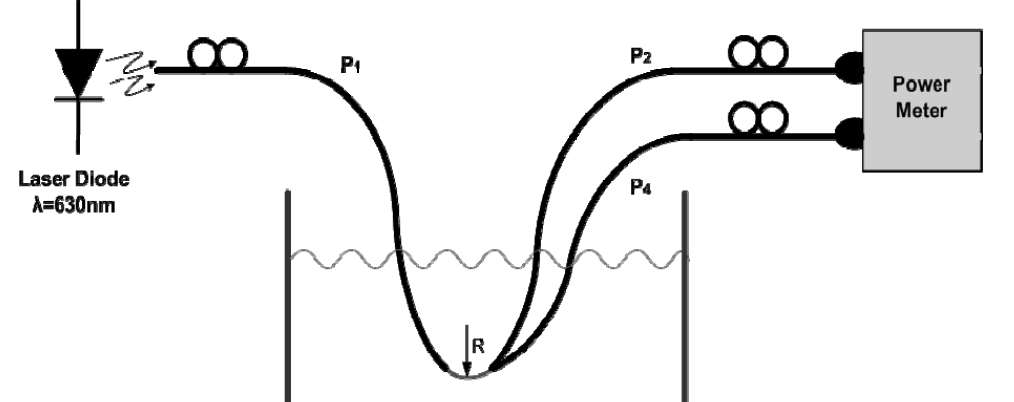
Figure 4. POF sensor set-up for determination of liquid level in